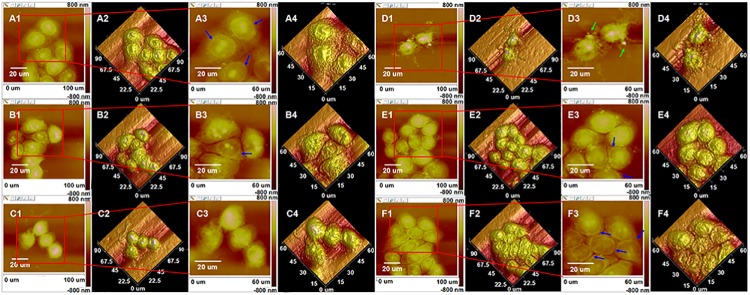
ROS scavenger-NAC reversed oridonin induced cell morphology damage of oesophageal cancer KYSE-150 cells.AFM morphology imaging of (A) control, (B) 10 μM oridonin treated, (C) 30 μM oridonin treated, (D) 50 μM oridonin treated, (E) 2.5 mM NAC+50 μM oridonin treated and (F) 2.5mM NAC treated KYSE-150 cells. (A1-F1) Topography images and (A2-F2) their corresponding 3D images of KYSE-150 cells; (A3-F3) Enlarged topography images in (A1-F1) and (A4-F4) their corresponding 3D images of KYSE-150 cells, scale bar: 20 μm.